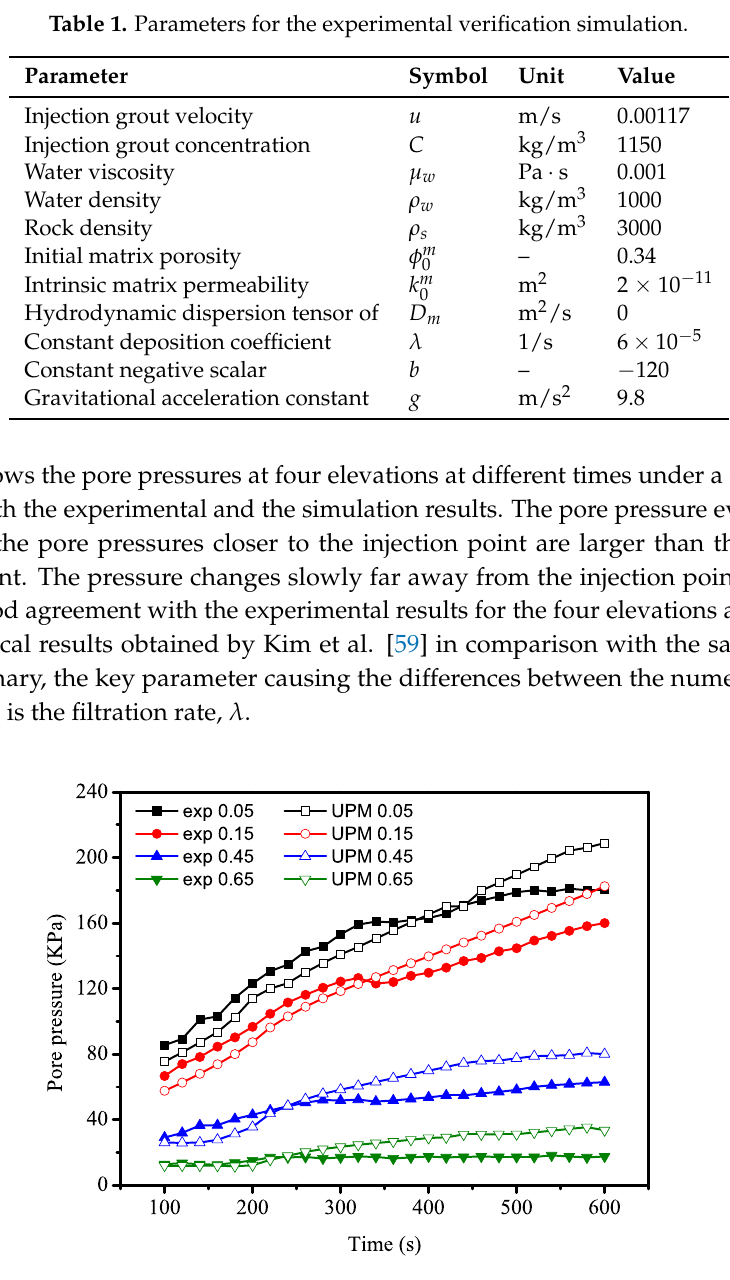
Figure 3. Comparison between the UPM model and the results obtained by Bouchelaghem